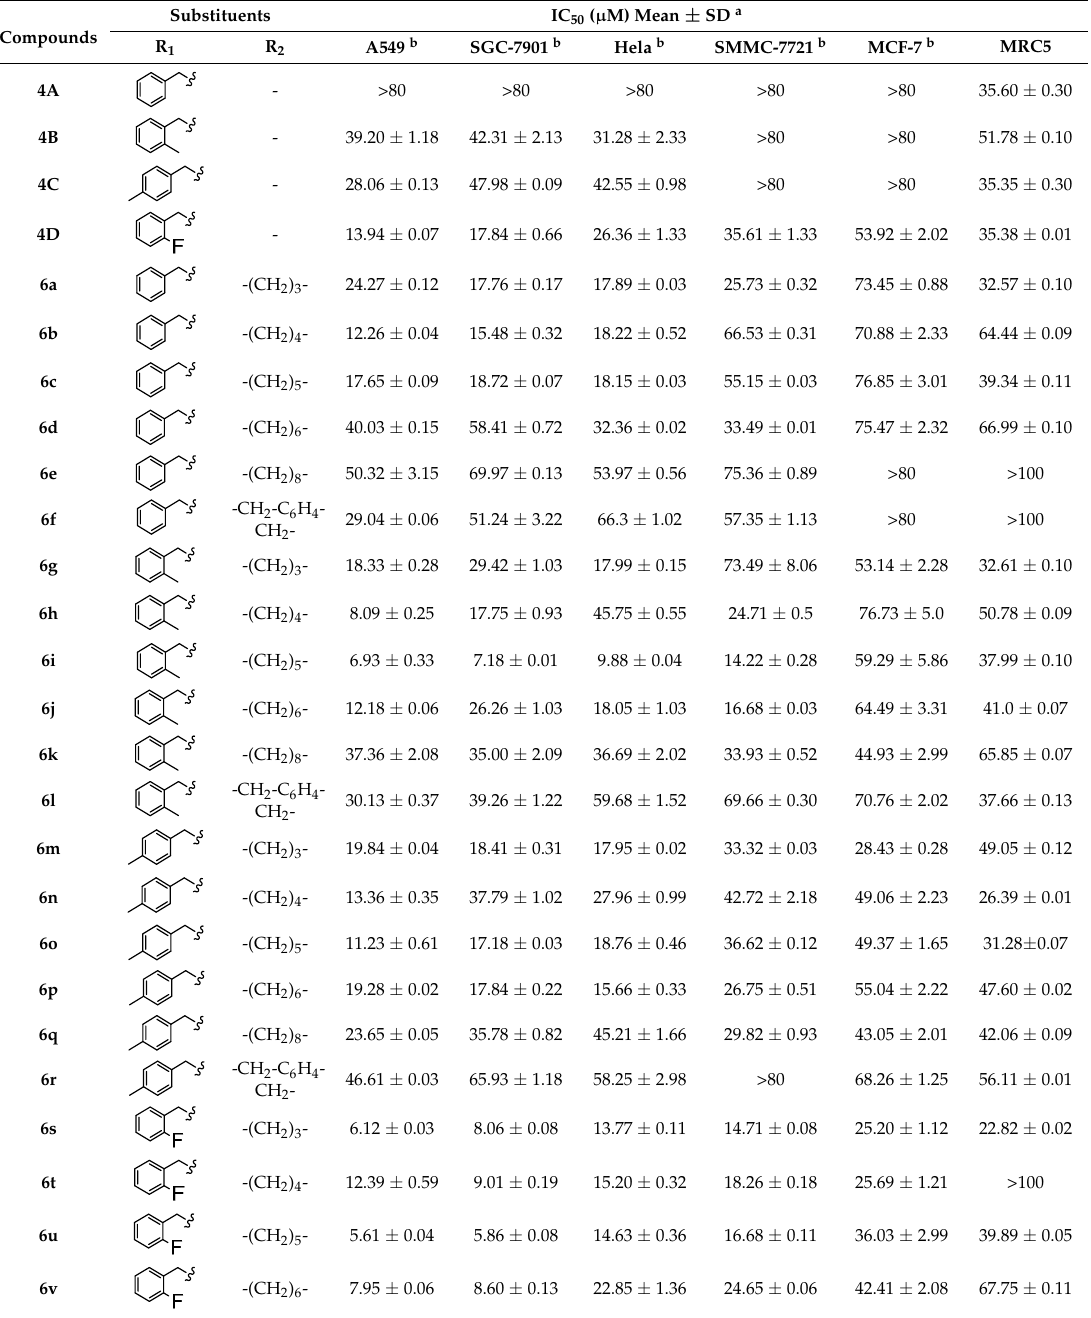
Table 1. The IC 50 values ( μ M) of β -carboline monomers ( 4A , 4B , 4C , and 4D ) and bivalent β -carboline derivatives ( 6a-6f , 6g-6l , 6m-6r , and 6s-6x ) against A549, SGC-7901, Hela, SMMC-7721, MCF-7, and MRC5 cell lines.